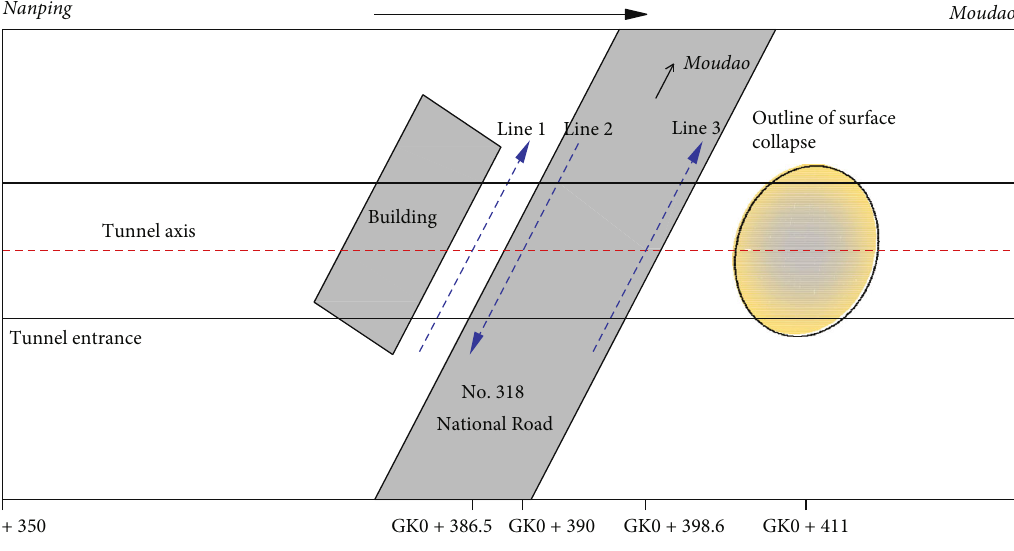
Figure 4: Survey line layout on the ground